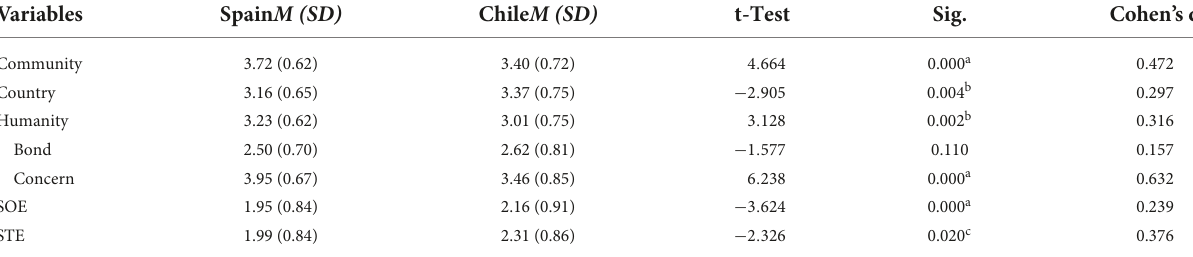
TABLE 4 Means, standard deviations of the study variables, between-country t -test comparisons and effect